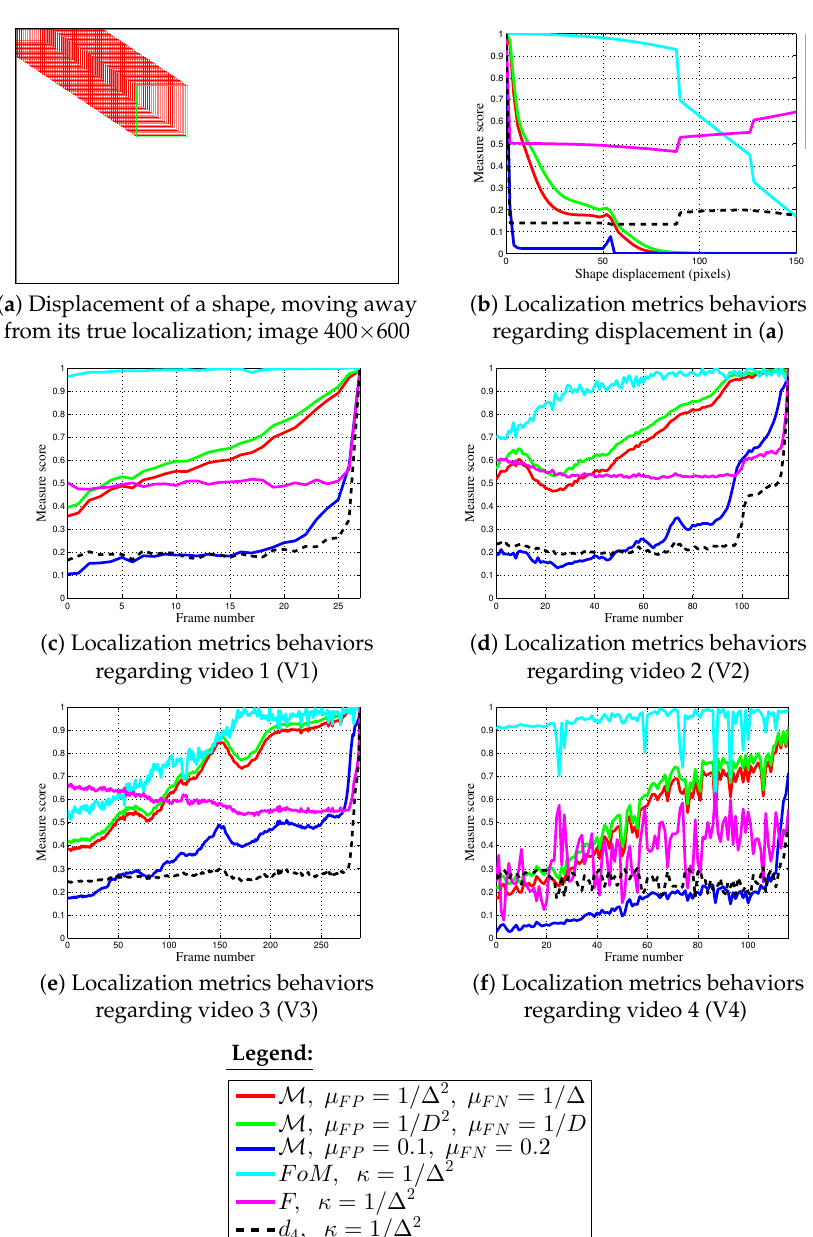
Figure 13. Comparison of score evolution regarding synthetic and real videos 4 × reduced with κ = 1/ ∆ 2 for FoM , F and d 4 shape measures. Different parameters tied to M : µ FP and µ FN are also